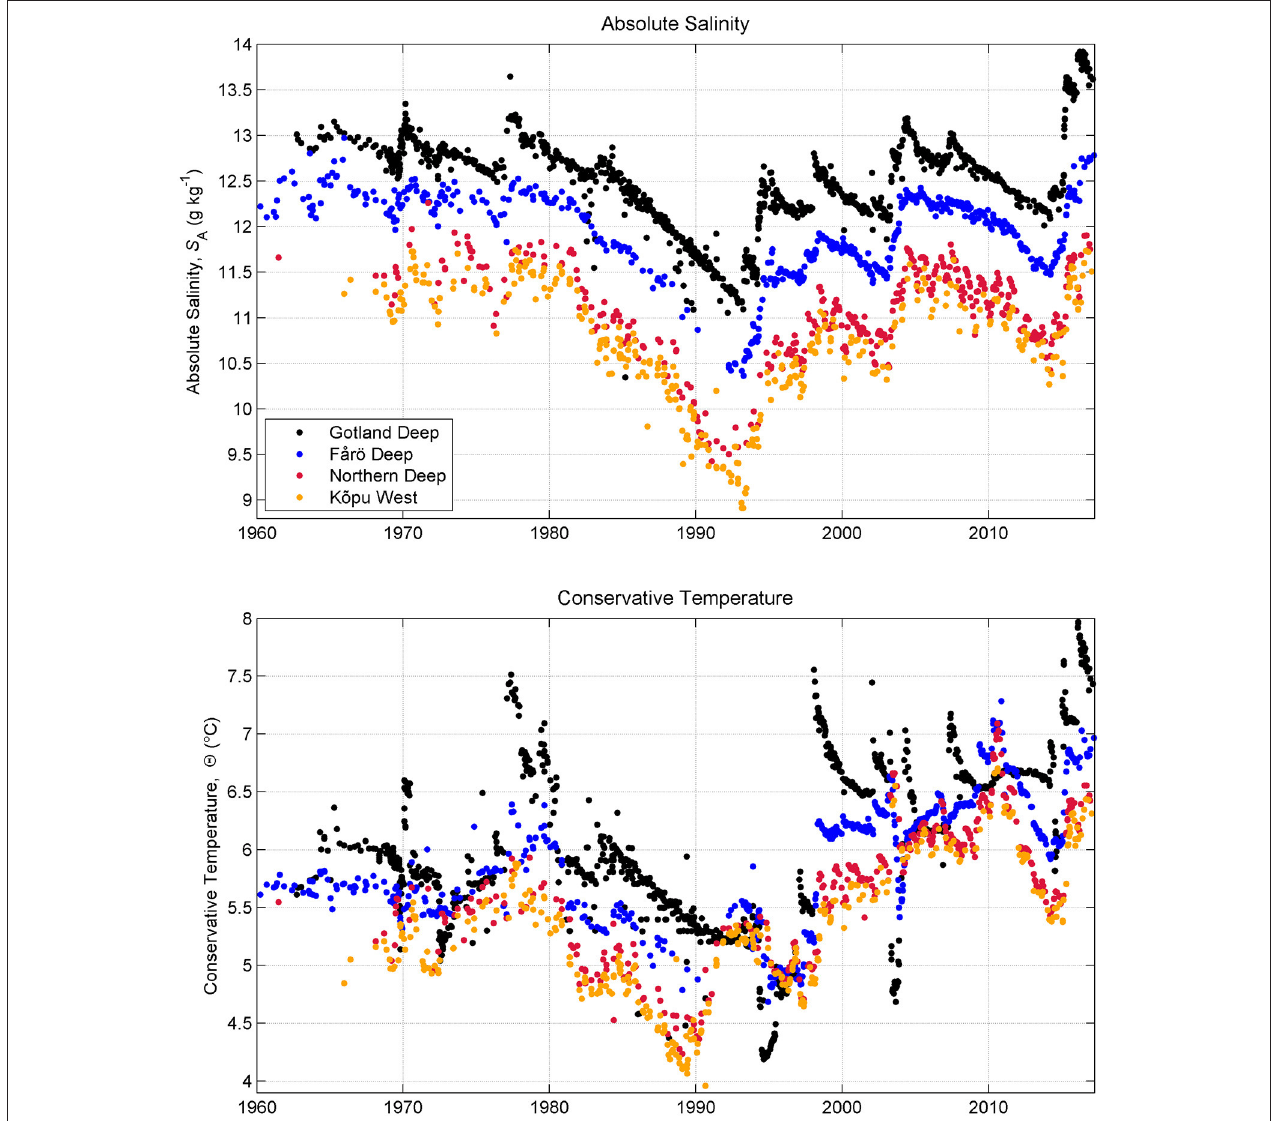
FIGURE 11 | Time series of salinity and temperature in the Gotland Deep (228m depth), Fårö Deep (193m depth), Northern Deep (173m), and Kõpu West (168m) in 1960–2017. The daily mean was calculated when there was more than one CTD cast available. Note that the deepest bin was chosen at the depth, where enough measurements were available. It means, in some cases, occasional deeper measurements might show slightly higher values. For example, the highest salinity during the study period, 14.1g kg − 1 , was observed in the Gotland Deep at 235m depth on 16 February